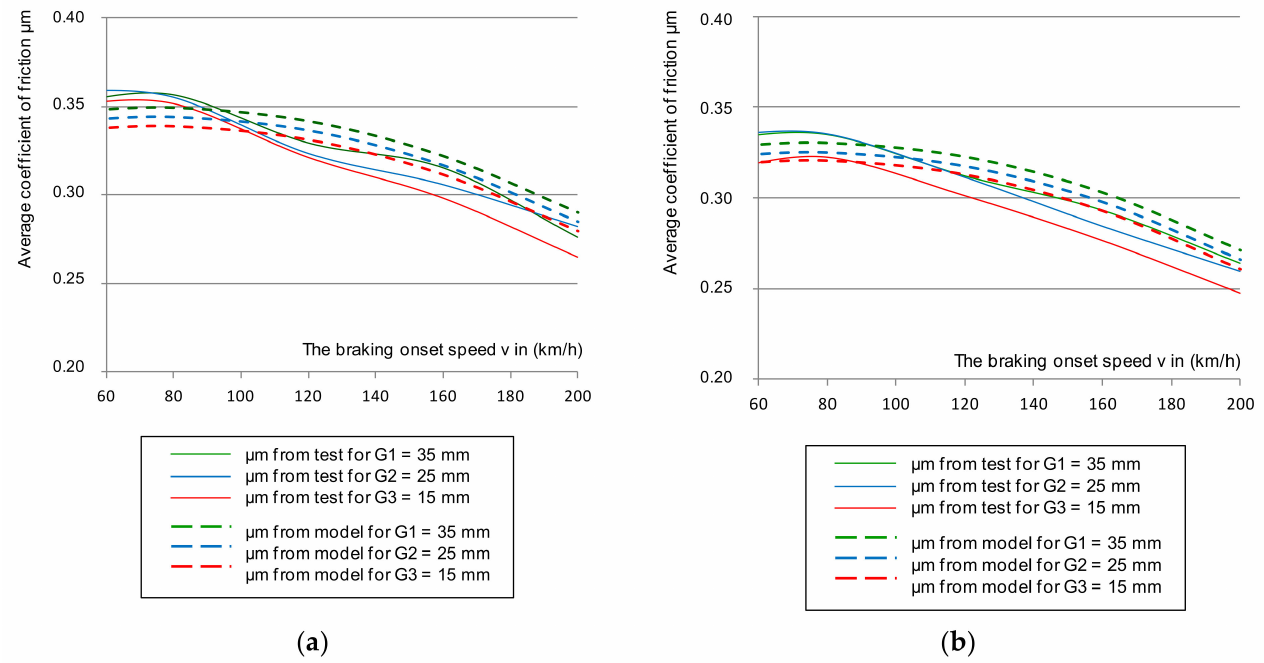
Figure 11. The µ m changes from the tests with the multiple regression model during braking with N = 44 kN, M = 7.5 t for: ( a ) new disc, ( b ) worn